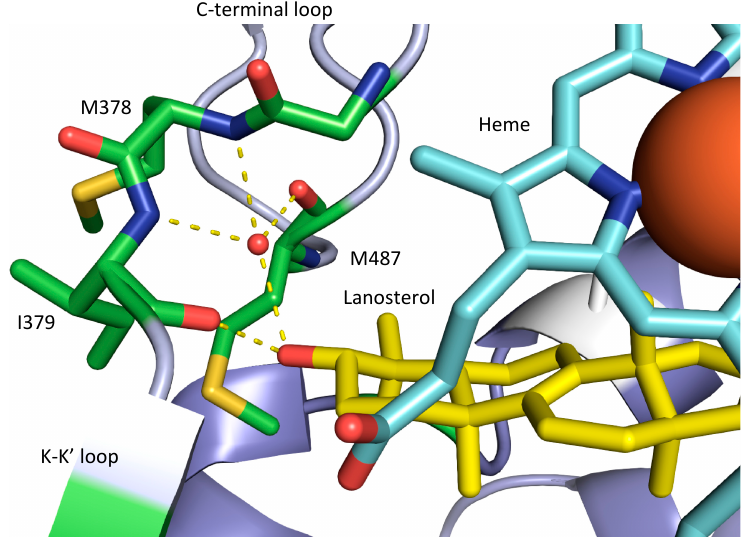
Figure 2. Structural view of the ligand-binding pocket of the human CYP51 D231A H314 mutant catalytic domain (Protein Data Bank ID: 6UEZ) interacting via hydrogen bonds (yellow dashes) with the hydroxyl of lanosterol (carbons in yellow). The heme is given in blue with the iron as a large red ball. Amino acid residues involved in the hydrogen bonding directly or as part of a water-mediated network are indicated. A list of all key AA residues for the main structures of the SDM are given in Supplementary Table S3.